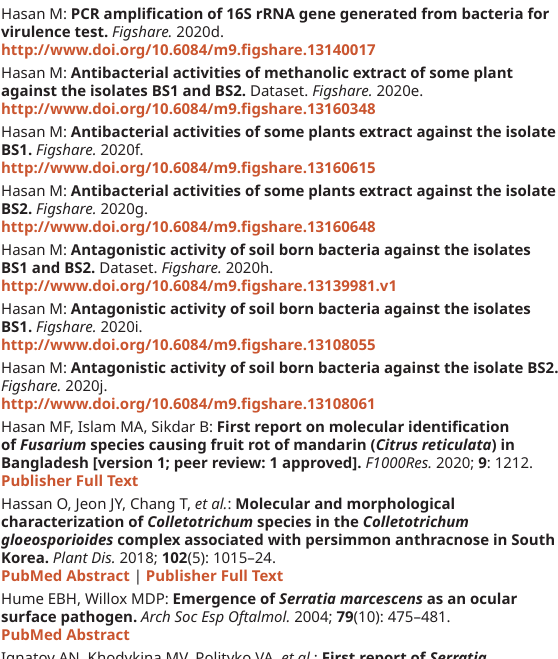
Figshare: Antagonistic activity of soil born bacteria against the isolates BS1 and BS2, https://doi.org/10.6084/m9.figshare.